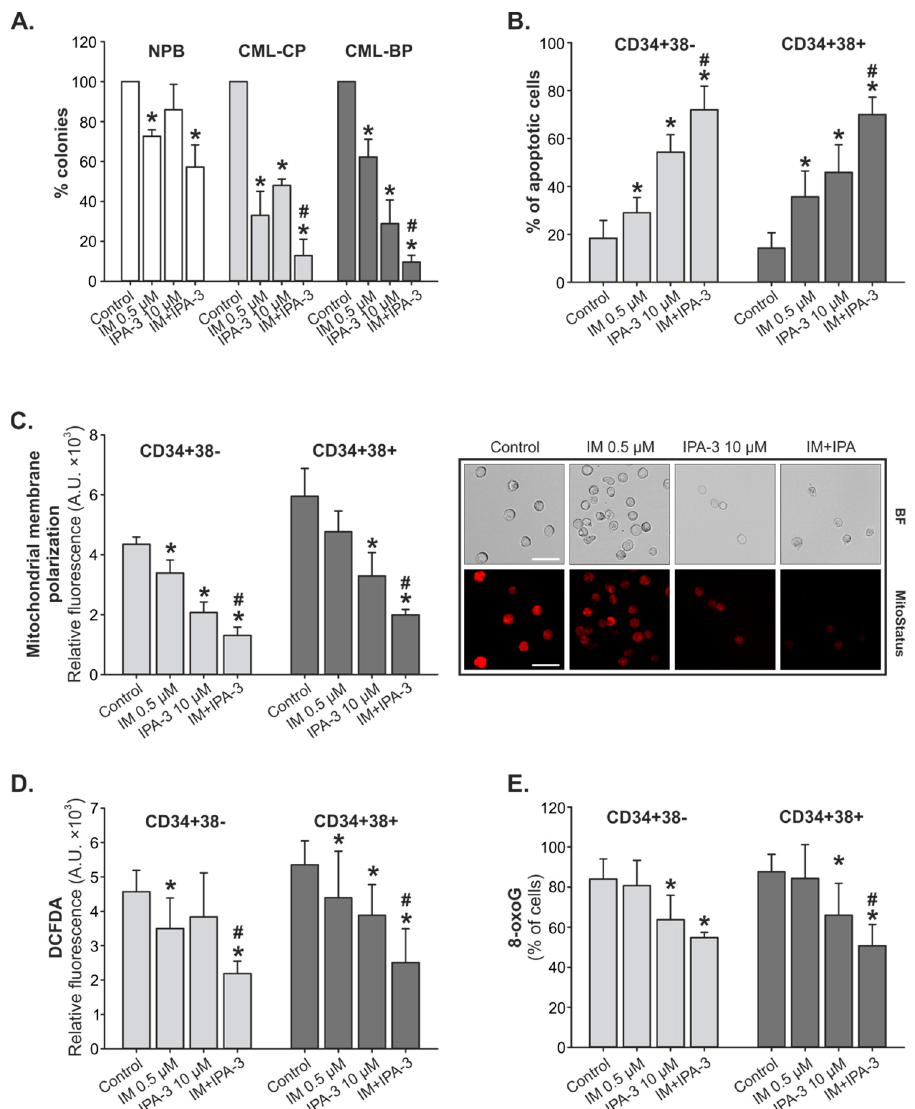
Figure 3. Effect of combination of IM and IPA-3 on primary chronic myeloid leukemia (CML) cells. ( A ) Clonogenic assay. Lin¯CD34 + primary cells obtained from healthy donors (NPB, n = 3) and from patients with chronic myeloid leukemia in the chronic phase (CML-CP) ( n ≥ 5) and CML-BP ( n = 3) were incubated with IM, IPA-3, and their combination for 72 h in the presence of growth factors. Mean percentage of colonies ± SD from triplicates, * p ≤ 0.01 in comparison to control ( C ), and # p ≤ 0.01 in comparison to IM using one-way analysis of variance Student–Newman–Keuls Method. ( B ) Apoptosis detection. Mean intensity of annexin V-fluorescein isothiocyanate (FITC) / propidium iodide (PI) staining ± SD ( n = 8). * p ≤ 0.004 in comparison to ( C ) and # p ≤ 0.001 in comparison to IM. ( C ) Mitochondrial membrane potential. Mean fluorescence intensity (MFI) of MitoStatus Red ± SD ( n = 3), * p < 0.008 in comparison to ( C ), # p < 0.003 in comparison to IM. Representative microphotographs present Lin¯CD34 + primary cells obtained from patients with CML-CP were treated with IM, IPA-3, and their combination for 24 h. A decrease in red fluorescence intensity reflects loss of mitochondrial membrane potential visualized under a fluorescent microscope ZOE Fluorescent Cell Imager, magnification 70 × , scale bar 28 µ m. ( D ) Intracellular level of reactive oxygen species. Mean 2’,9’-dichlorodihydrofluorescein-diacetate (DCFDA) staining ± SD ( n ≥ 5), * p < 0.05 in comparison to ( C ). ( E ) DNA damage. Mean 8-oxoguanine (8-oxoG) fluorescence ± SD ( n ≥ 5), * p < 0.05 in comparison to ( C ), # p < 0.02 in comparison to